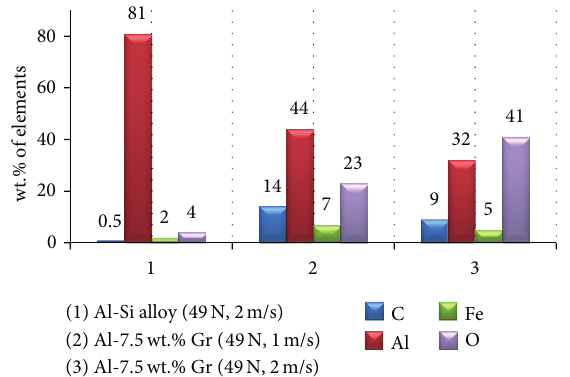
Figure 16: Mass percentage of Al, Fe, C and oxides as a function of sliding velocities on the worn surface of the Al alloy and Al-7.5wt.% Gr composite against the counter steel obtained by